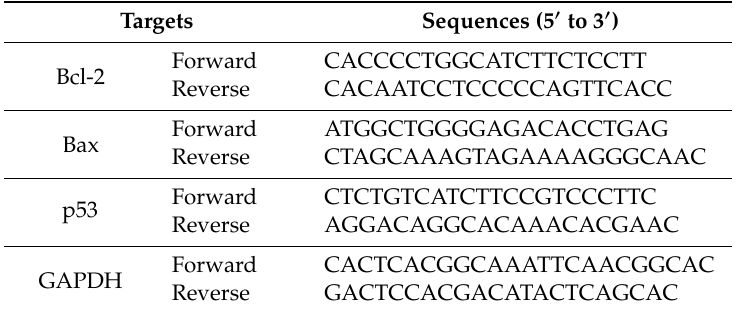
Table 2. Primer sequences used for the semi-quantitative RT-PCR in this study.